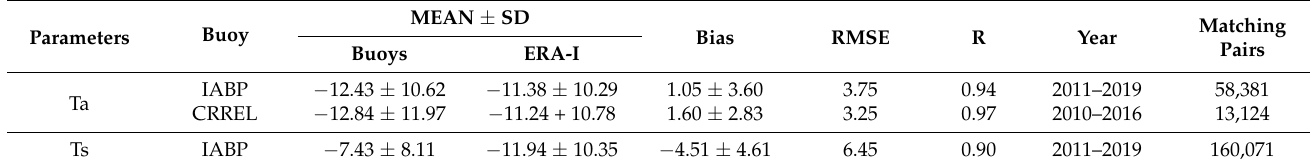
Table 8. Estimated biases for the Ta and Ts from the ERA-I for different buoy